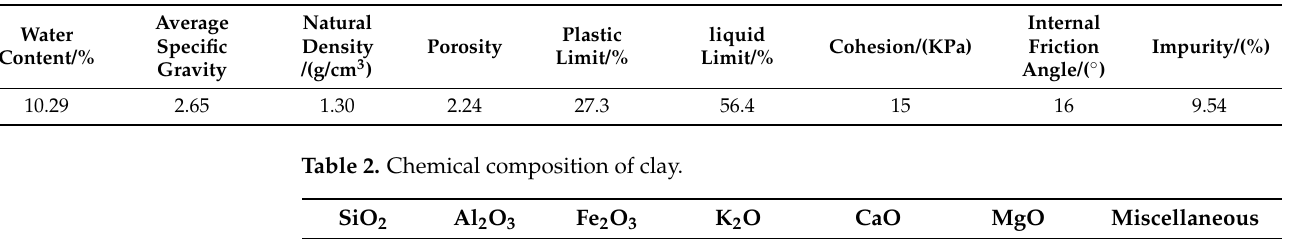
Table 1. Physical parameters of the soil samples.